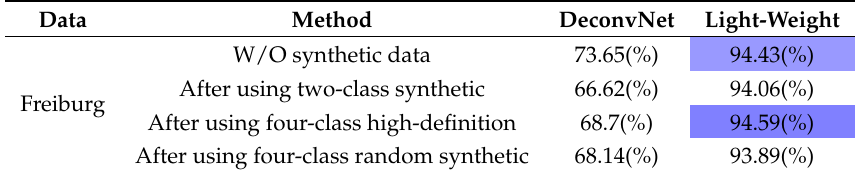
Table 4. Quantitative results produced by DeconvNet and the proposed network for various TL experiments. Shading indicates the improvement of one method over